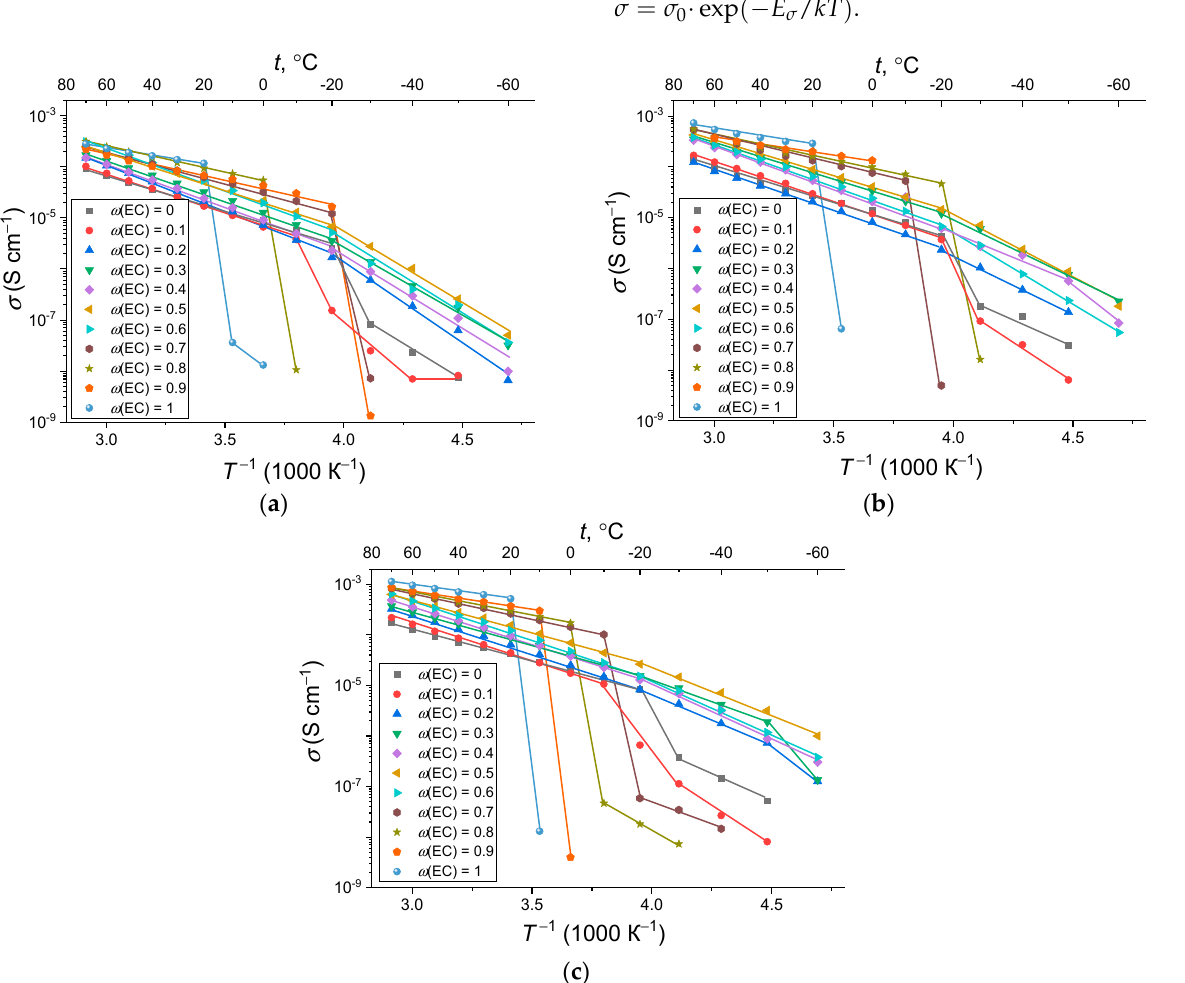
Figure 5. Temperature dependence of ionic conductivity of the Na-Nafion membranes, swollen at ( a ) 40 °C, ( b ) 60 °C, ( c ) 80 °C. It can be seen that the membranes swollen in a mixture with ω (EC) = 0.2–0.6